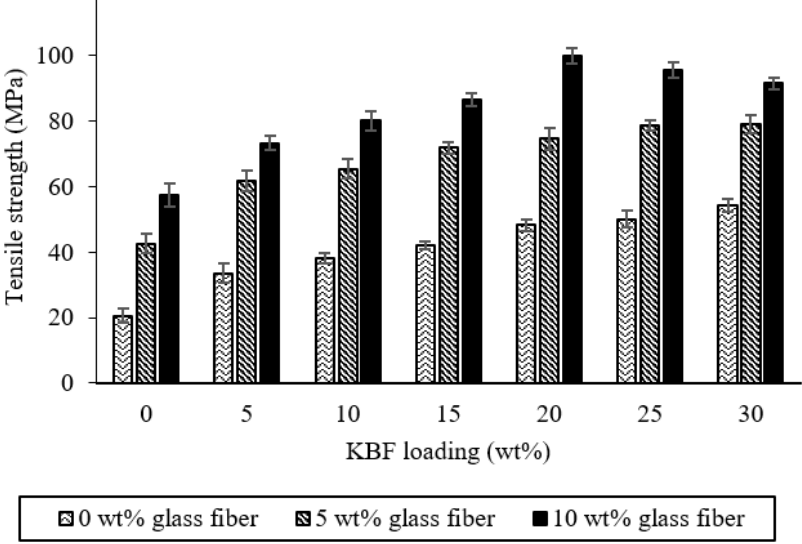
Figure 8. Effect of KBF and GF loading on tensile strength of hybrid MA-treated kenaf bast/GF- reinforced UPE composites.